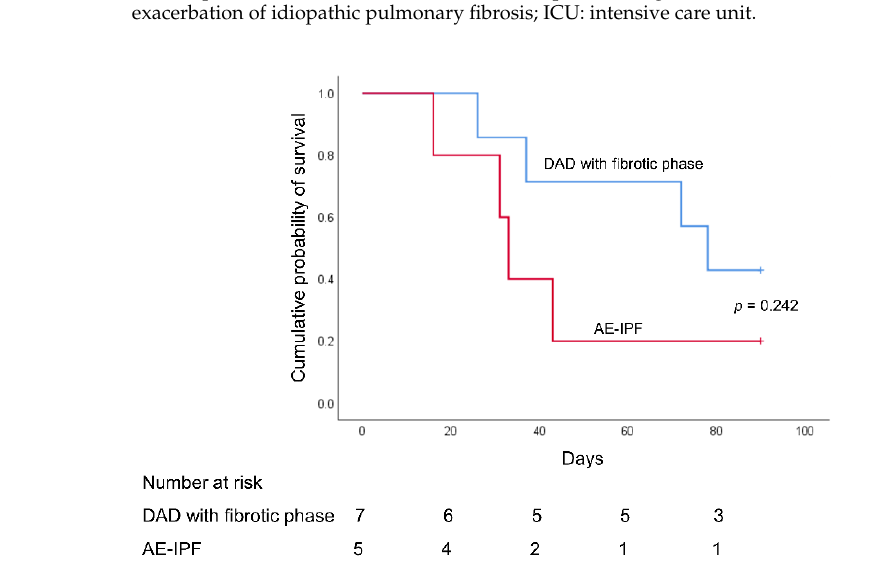
Figure 4. Kaplan–Meier 90-day survival curves of patients with acute respiratory distress syndrome undergoing open lung biopsy, as stratified by DAD with a fibrotic phase and AE-IPF. DAD: diffuse alveolar damage; AE-IPF: acute exacerbation of idiopathic pulmonary fibrosis.